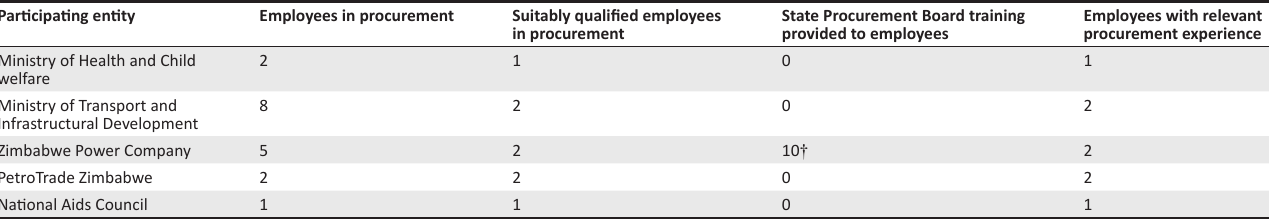
TABLE 3: Procurement background of employees. Participating entity